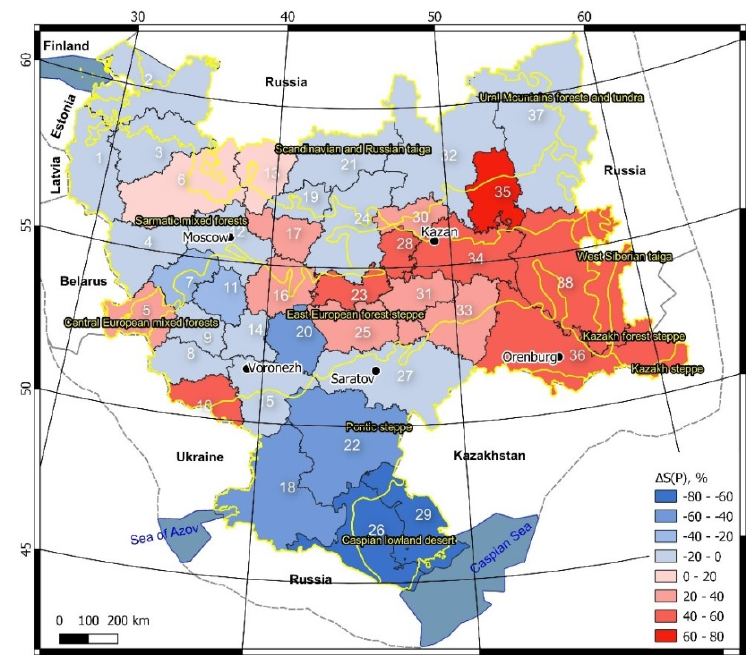
Figure 5. Relative changes in cultivated land area under perennial crops ( ∆ S(P)) within the analyzed administrative regions of European Russia between 1970–1987 and 1996–2017. For other symbols, see Figures 2 and 3.